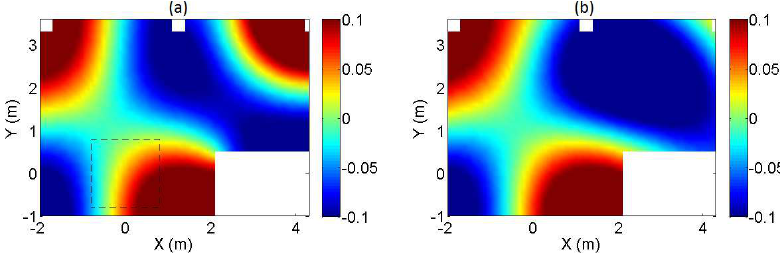
Figure 8. Target ( a ) and reconstructed ( b ) field of the reference room, regularized β =